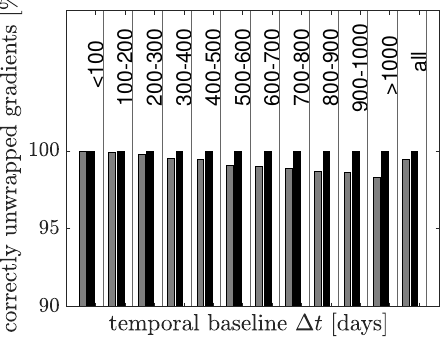
Figure 7. Percentage of correctly unwrapped phase gradients depending on the temporal baseline. The results of the extended minimum cost flow (EMCF) algorithm are shown as black bars. The gray bars represent the results of the MCF algorithm without considering the temporal